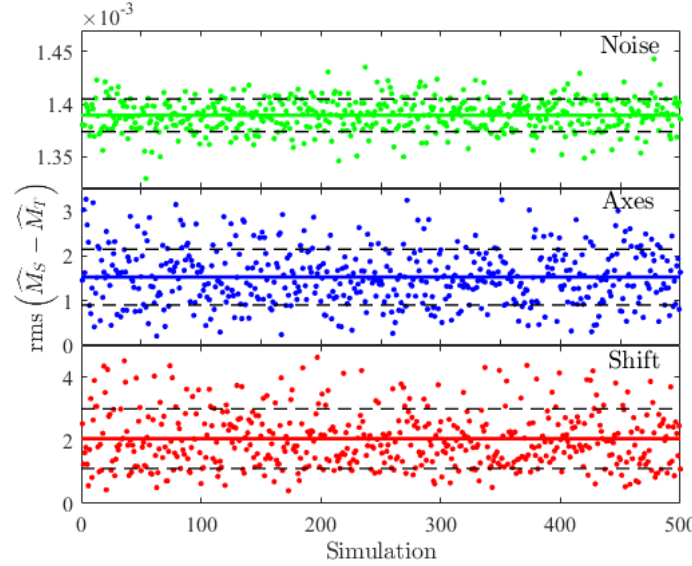
Figure 2. Root mean square of the differences between the theoretical Mueller matrix and the calculated one from each individual realization of the simulated experiment for air as sample. Different sources of errors are considered. Color solid lines indicate the mean value for each case and dashed black lines are at a one standard deviation distance of the mean